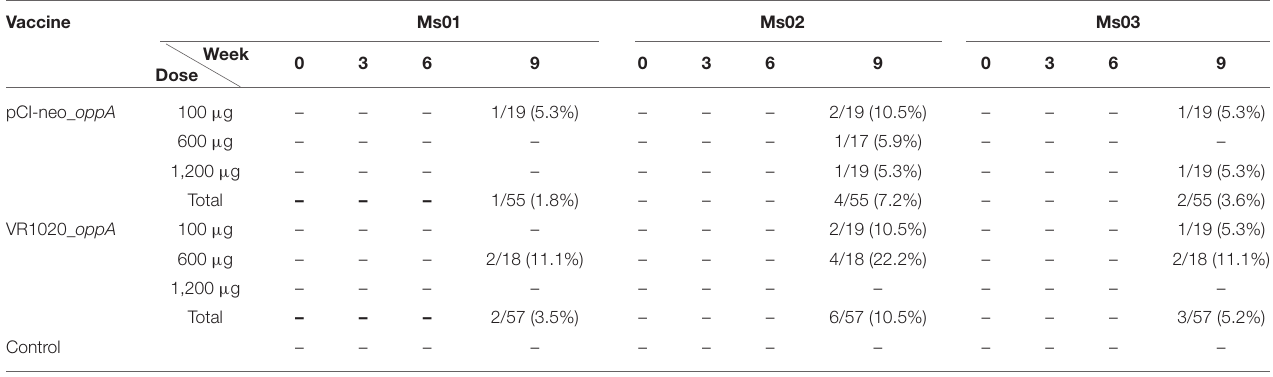
TABLE 2 | Summary of mycoplasma infections detected during the vaccine trial using PCR.